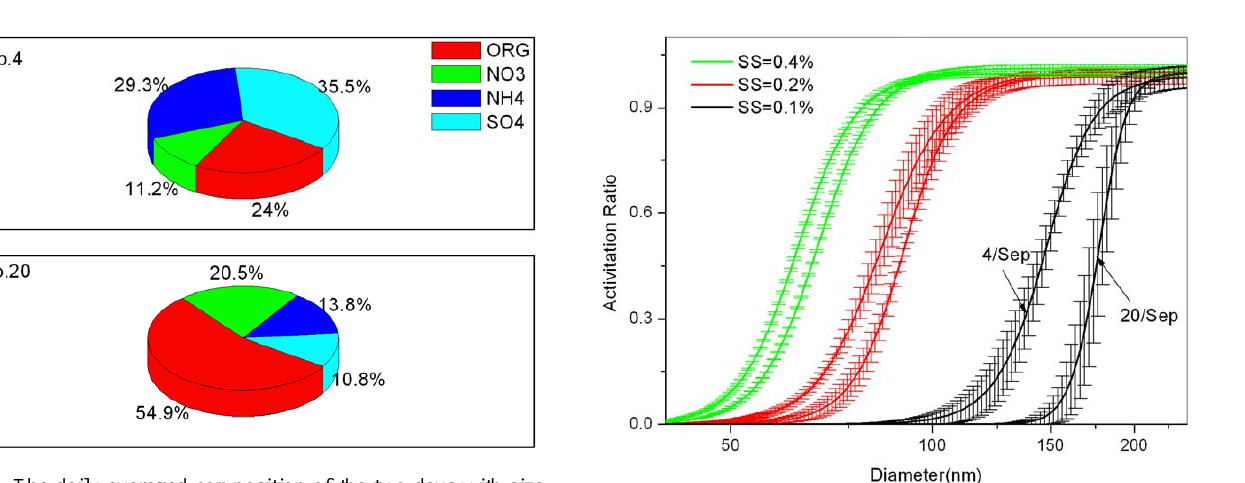
Fig. 7. The daily averaged composition of the two days with size ranging from 50 to 200nm on 4 September and 20 September. Fig.7 the daily averaged composition of the two days with size ranging from 50 to 3 200nm on 4/Sep and 20/Sep 4